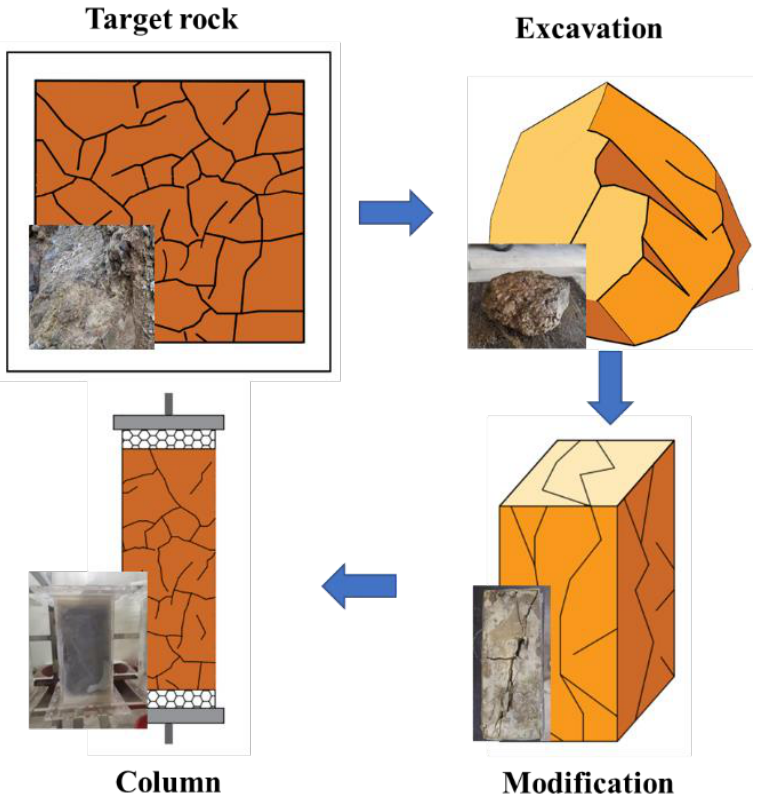
Figure 2. Collection process of shale samples.